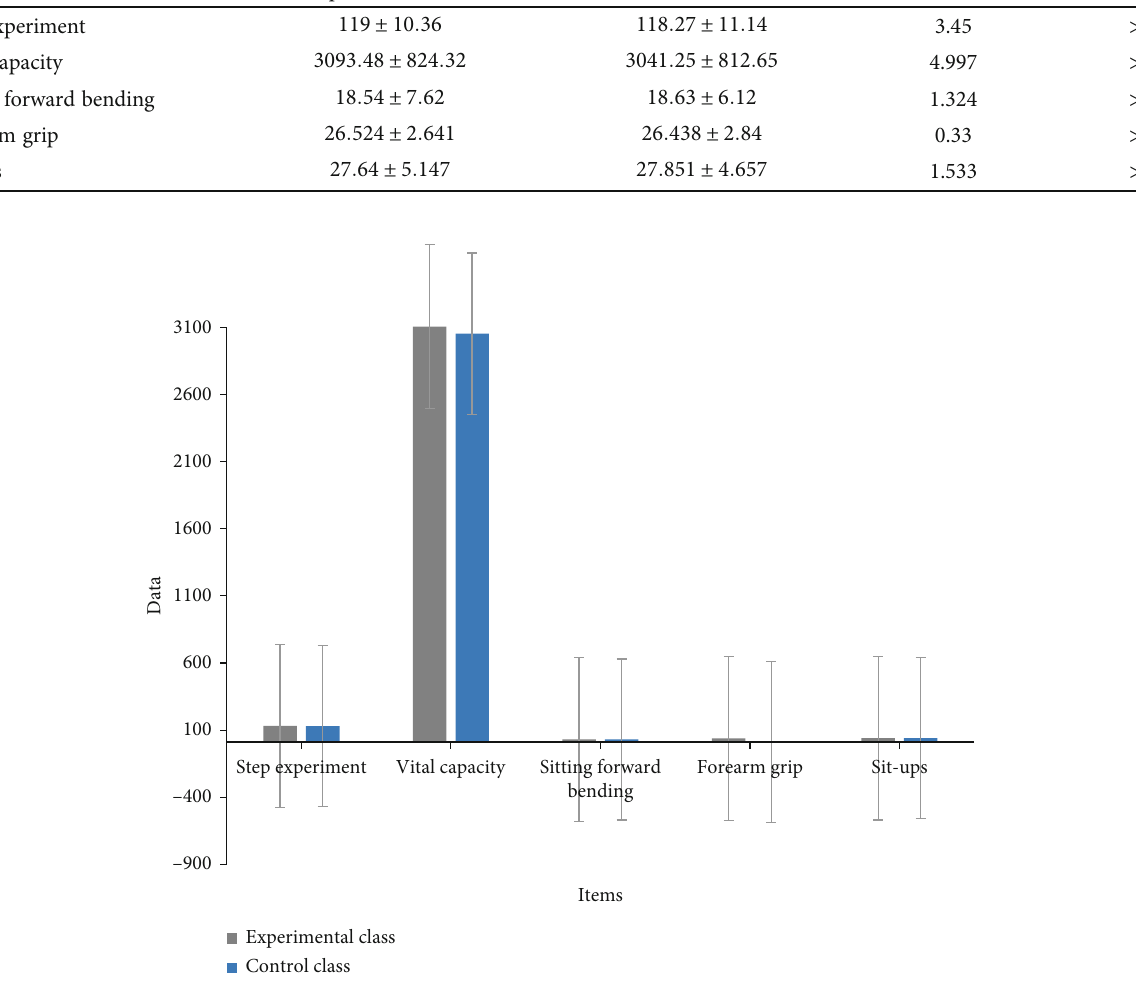
Figure 1: Comparative analysis of test results of students ’ health and physical fi tness index before